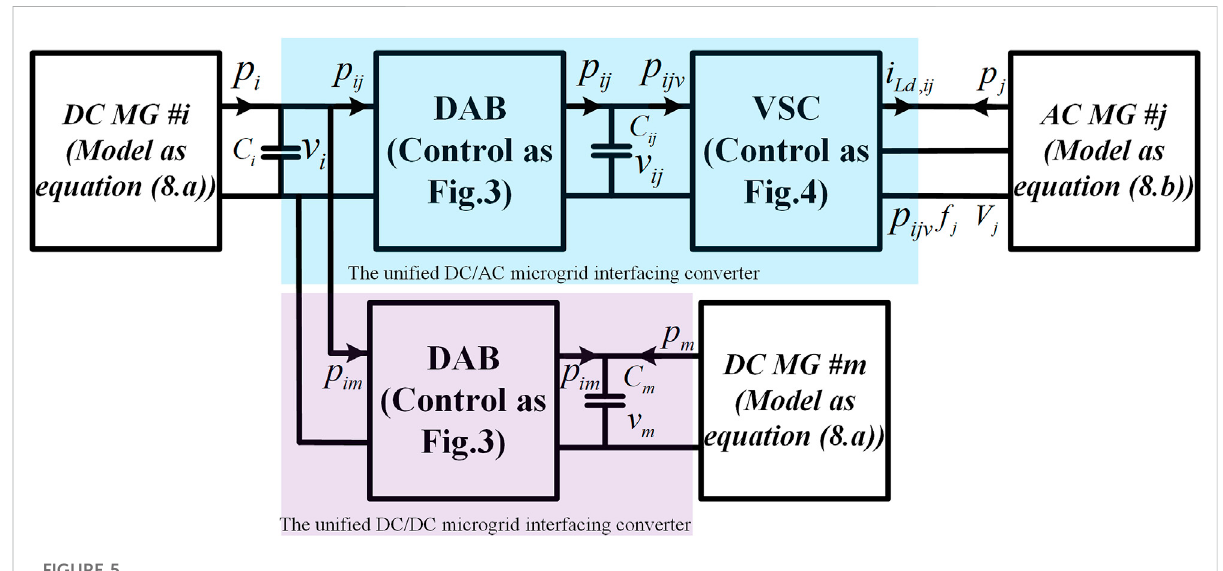
FIGURE 5 Simpli fi ed schematic of the three-microgrids system for